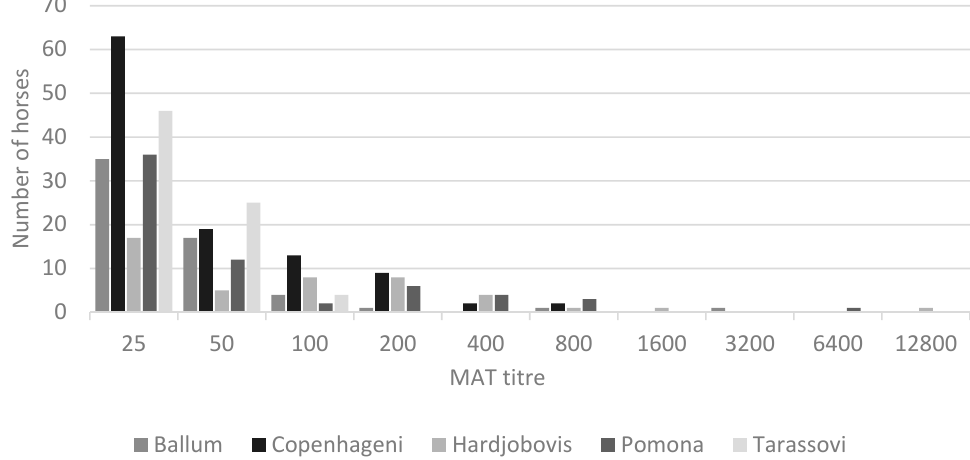
Figure 1. Frequency of microscopic agglutination titres (cut-off of ≥ 25) for Ballum, Copenhageni, Hardjo (bovis), Pomona, or Tarassovi in a convenience sample of 499 racehorses and broodmares in New Zealand.